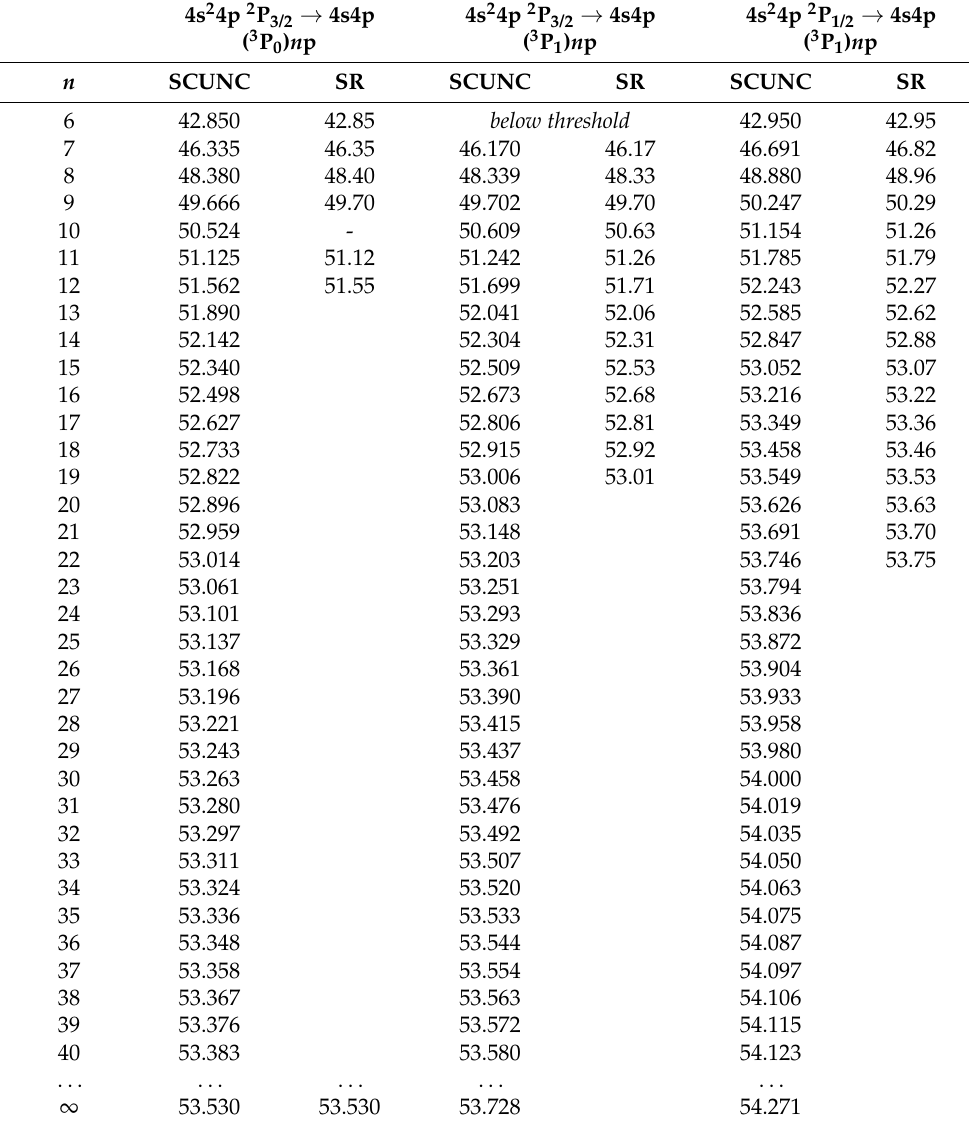
Table 1. Resonance energies of the 4s4p ( 3 P 0,1 ) n p Rydberg series originating from the 4s 2 4p 2 P 1/2,3/2 states of Se 3+ converging to the 3 P 0,1 series limits in Se 4+ . The Screening constant per unit nuclear charge (SCUNC) results are compared to the synchrotron radiation (SR) measurements of Esteves et al. [22]. The screening constants are equal to: f 1 ( 2 P 3/2 , 3 P 0 ) = − 6.579 ± 0.029, f 1 ( 2 P 3/2 , 3 P 1 ) = 2 P 3 P − 7.303 ± 0.029 and f − 7.365 ± 1 ( 1 ) = 1/2 ,